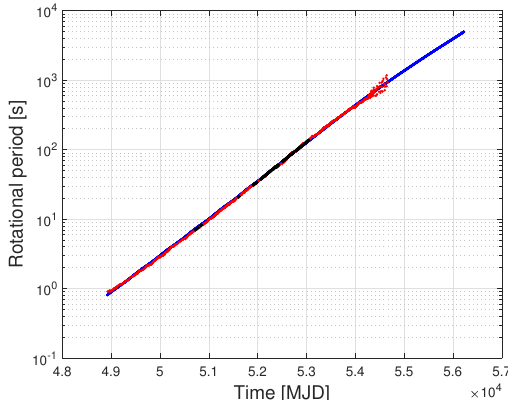
Figure 3. Spin evolution of LAGEOS II on the basis of the LASSOS model (blue dots), compared with observations (red and black). Rotational period ( P ) of the satellite as a function of time expressed in Modified Julian Date